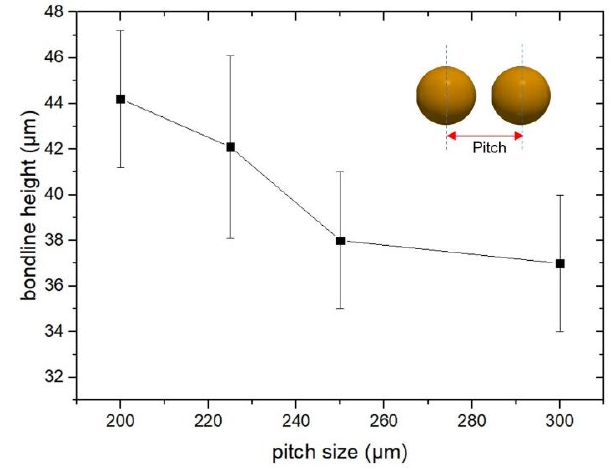
Figure 5. Bond frame height as a function of jetting pitch size.